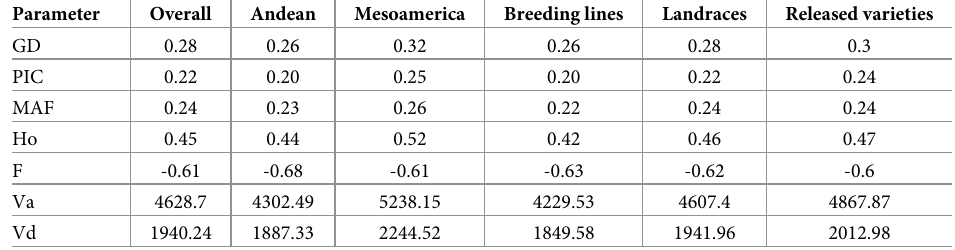
GD = Gene diversity, PIC = Polymorphic information content, MAF = Marker allelic Frequency, Ho = Observed heterozygosity, F = Fixation index, Va = additive variance, Vd = dominance